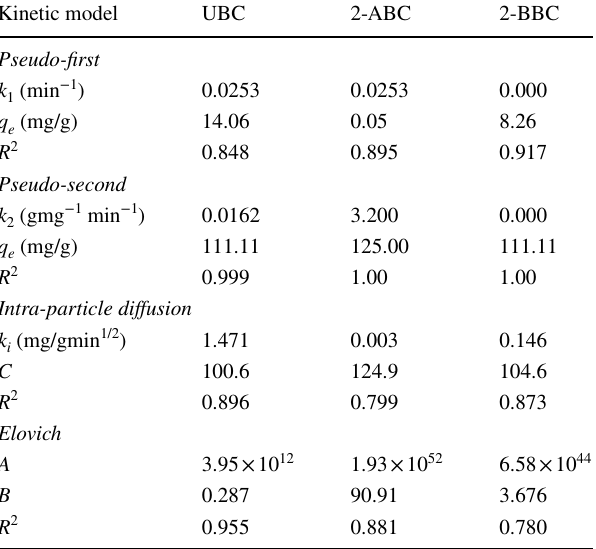
Table 2 Kinetic Parameters of Adsorption of